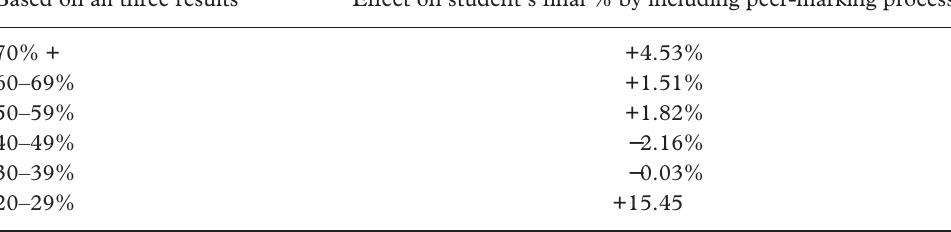
Table 9. Improvement based on performing peer-marking process Based on all three